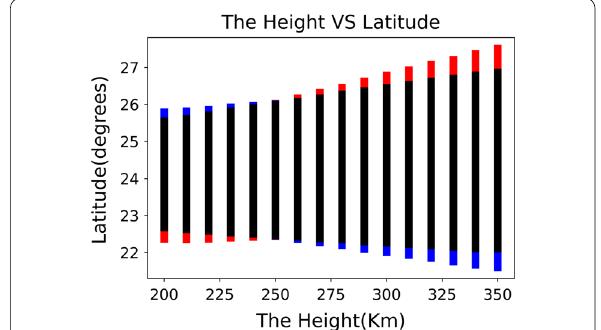
Fig. 7 The movement of shifting different heights for the penetration points from 200 to 350 km if the S4 index > 0.3. The blue color is for NCU station, black for TasoTun station and red for Checheng station